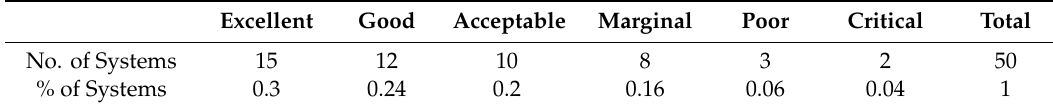
Table 1. Initial state vector using percentages of systems inspected. Excellent Good Acceptable Marginal Poor Critical